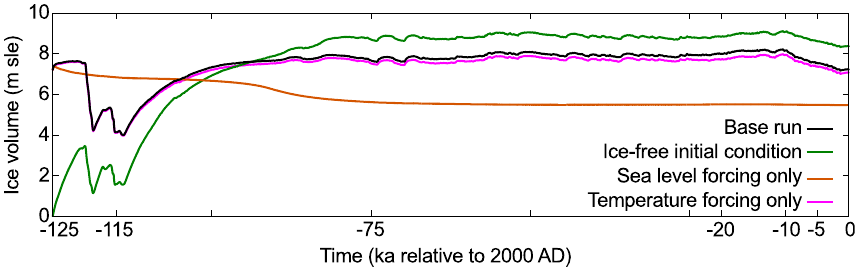
Fig. 8. Effects of initial condition on volume curves, and the relative influence of sea level and temperature on model output. All runs displayed in this figure use a parameter combination that closely matches the estimated modern ice volume (Bamber et al., 2001) using our standard setup (run #29; Supplement). The initial condition exerts some control over simulated ice volumes (especially during the late Eemian), whereas sea level is clearly a second-order control on simulated ice volumes when compared to temperature